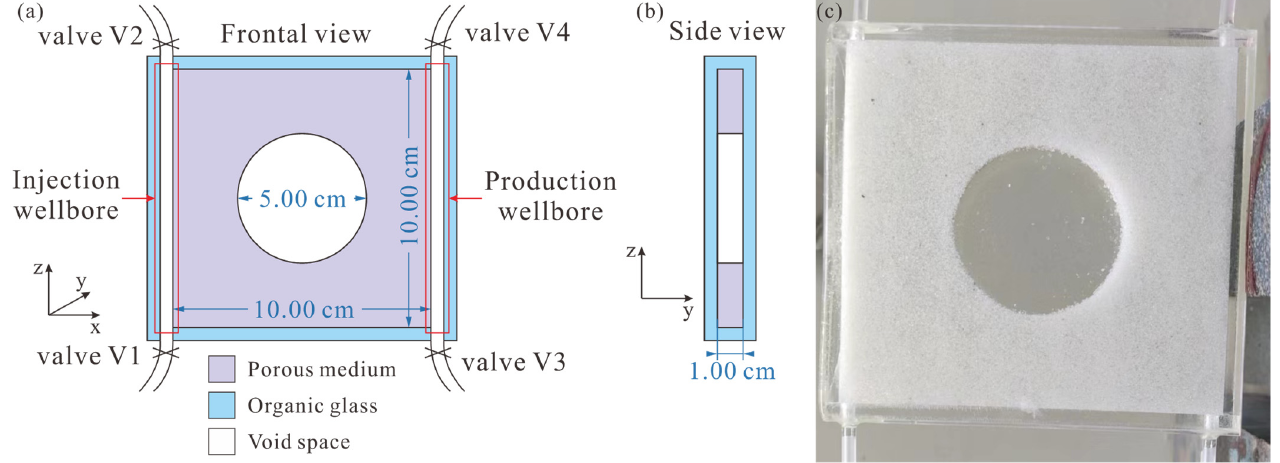
Figure 2. Schematic of the single-vug model. ( a ) Frontal and ( b ) side cross-sectional view, and ( c ) a manufactured sample of the physical model.